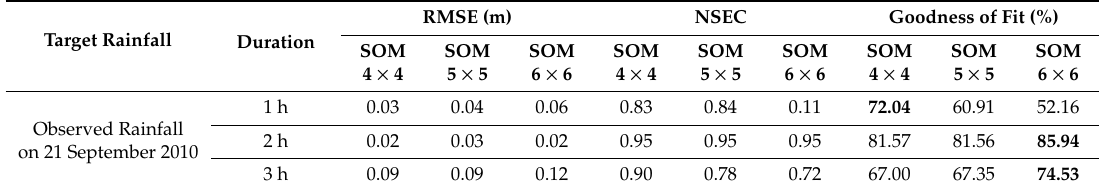
Table 6. Evaluation of Flood Map